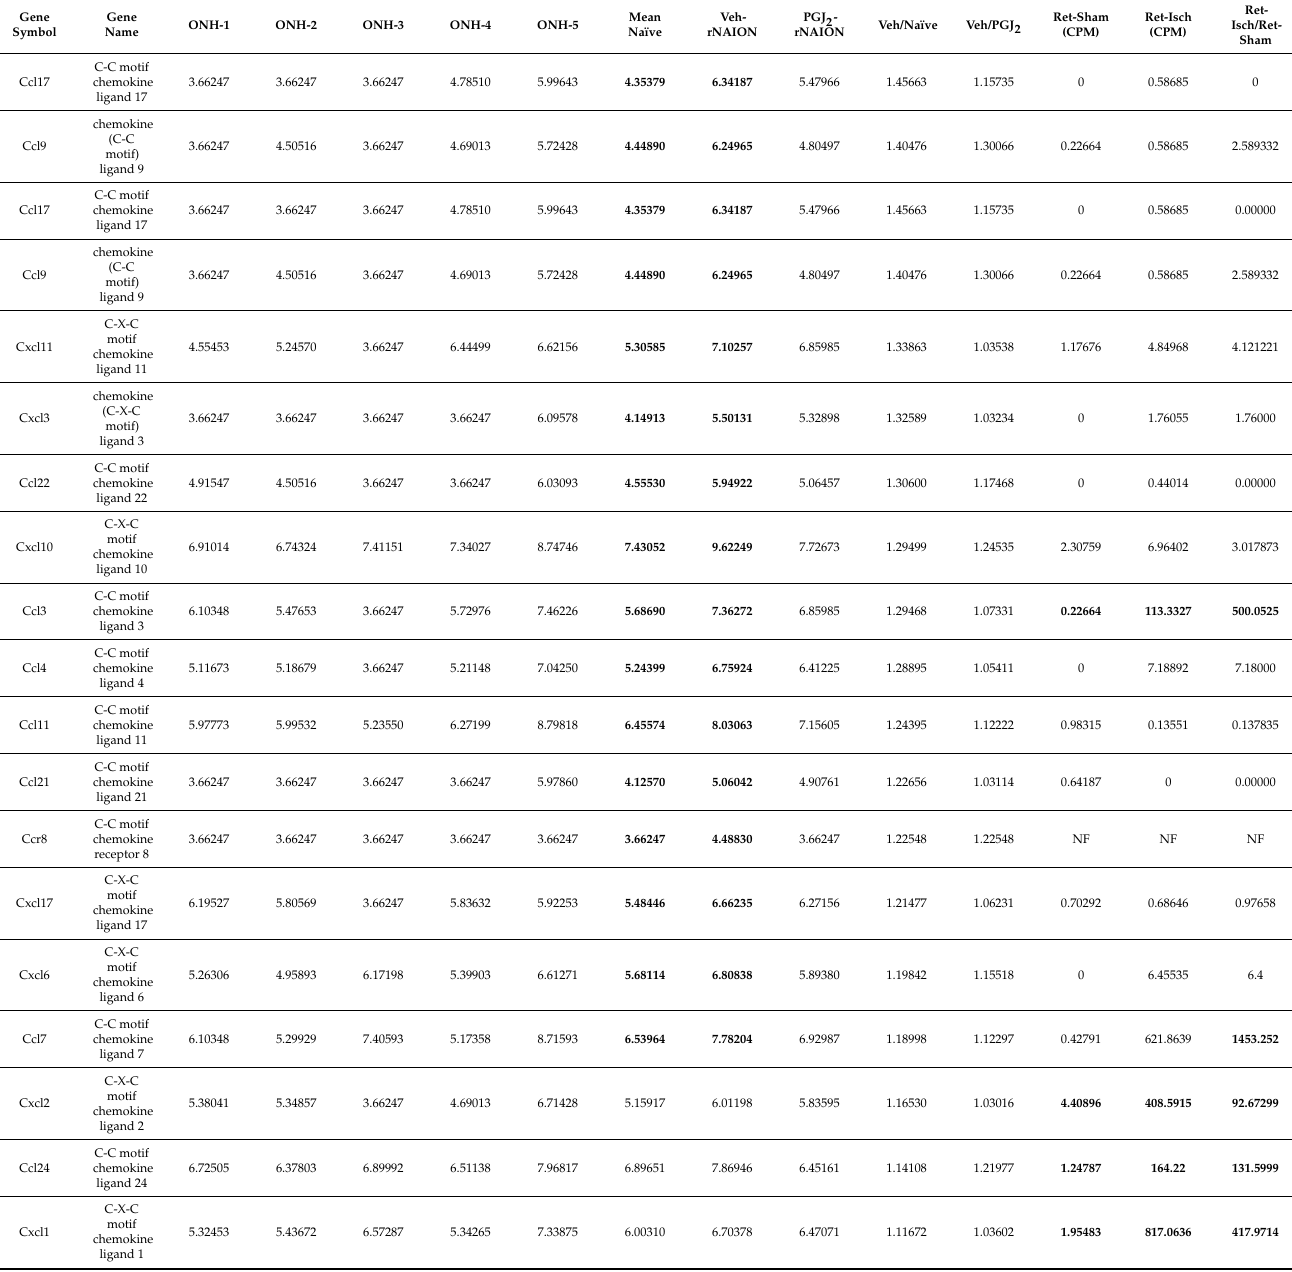
Table 5. List of selected chemokines and relative levels expressed in the ONH in naïve, rAION-vehicle-induced and rAION-PGJ 2 -treated animals. Illumina sequence data for ONH are based on Deseq2-normalized (log 2 -fold relative levels) expressed in ONH RNA from individual naïve, mean naïve ( n = 5), rAION-vehicle-induced and rAION-PGJ 2 -treated animals, using a cutoff of <3.4. Normalization is based on Trimmed Mean Values (TMM) and normalized by EdgeR-cpm function with a cutoff of 2. Naïve retina (retina-N) and ischemic retina (retina-Isch) are from [19] and expressed in counts per million (CPM). The ratio of expression in ischemic retina/sham retina values are shown in the last column. The two greatest ratio changes in retinal conditions are shown in bold. The total list is found in Supplemental Data Table S1. NF: not found. The total list is found in Supplemental Data Table